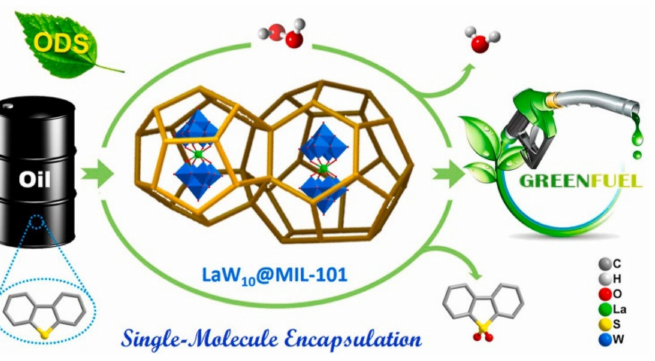
Figure 4. The LaW 10 guests were dispersed homogeneously in MIL-101(Cr) nanocages at molecular level and used as ODS catalyst (reproduced from Ref. [70], copyright 2021